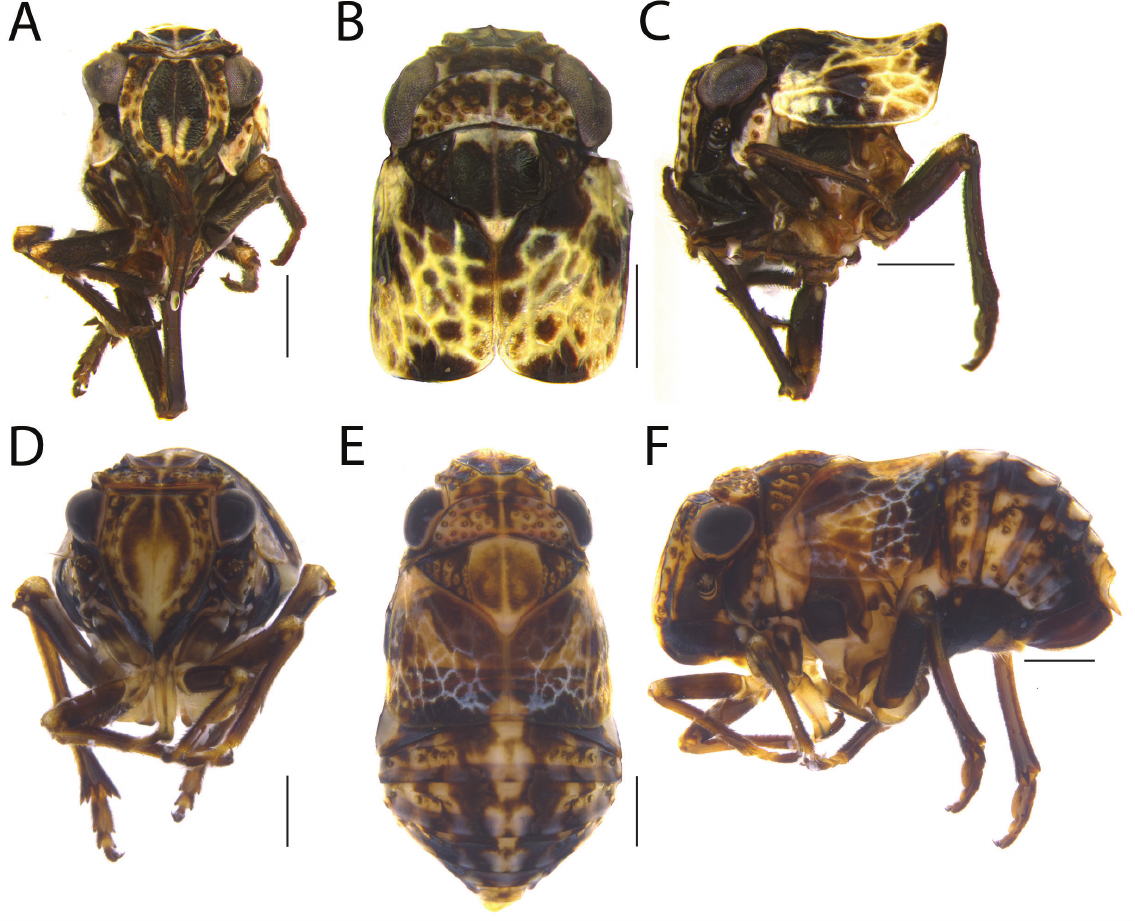
Fig. 3. Habitus of Bruchomorpha decorata Metcalf, 1923. A–C . ♂ (INHS). A . Frontal view. B . Dorsal view. C . Lateral view. D–F . ♀ (NMNH). D . Frontal view. E . Dorsal view. F . Lateral view. Scale bars = 0.5